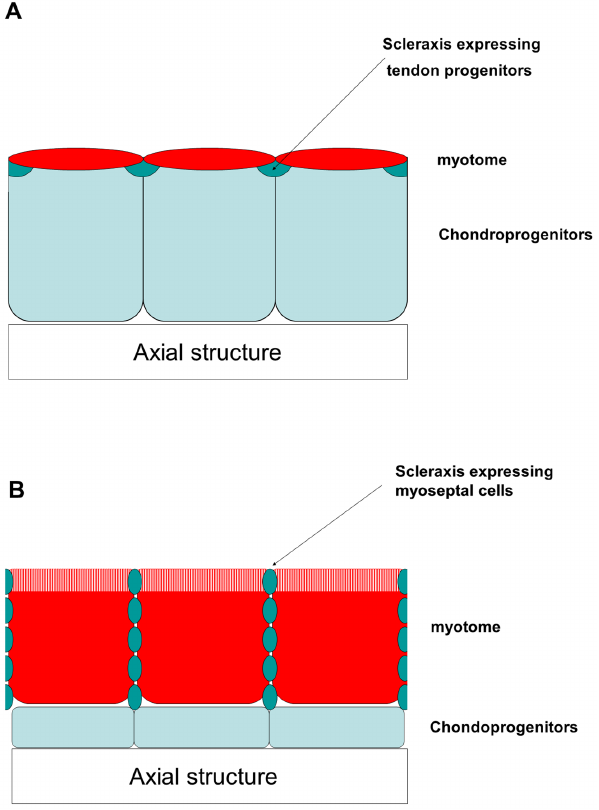
Figure 7. Comparison of the early axial musculoskeletal system between amniote and fish. Schematic frontal sections through trunk region of amniote ( A ) and fish embryos ( B ). ( A ) Amniote embryo. The sclerotome that derives from an important portion of the somite gives rise to chondroprogenitors surrounding axial structures (notochord and neural tube). Scleraxis expressing tendon progenitors originating from the dorsolateral edge of the early sclerotome lie between adjacent myotomes (adapted from [13]). ( B ) Fish embryo (17dpf). The sclerotome that represents a reduced somite derivative gives rise to a limited number of chondroprogenitors that express osteoblast-specific factor2/ periostin. Adjacent myotomes are separated by Scleraxis-expressing myoseptal cells. A dermomyotome (white and red vertical lines) at the surface of the myotome persists late during fish development and expresses high levels of col1a1 , col5a2 and col12a1